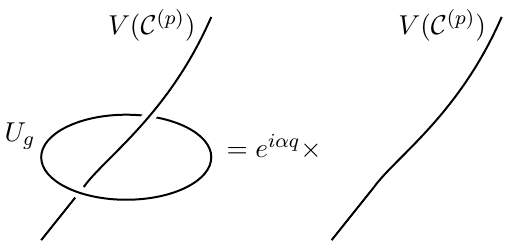
Figure 1 . The action of a p -form symmetry operator U α on a p -dimensional extended operator V ( C ( p ) ) . When U α surrounds C ( p ) , it acts by a phase exp( iαq )